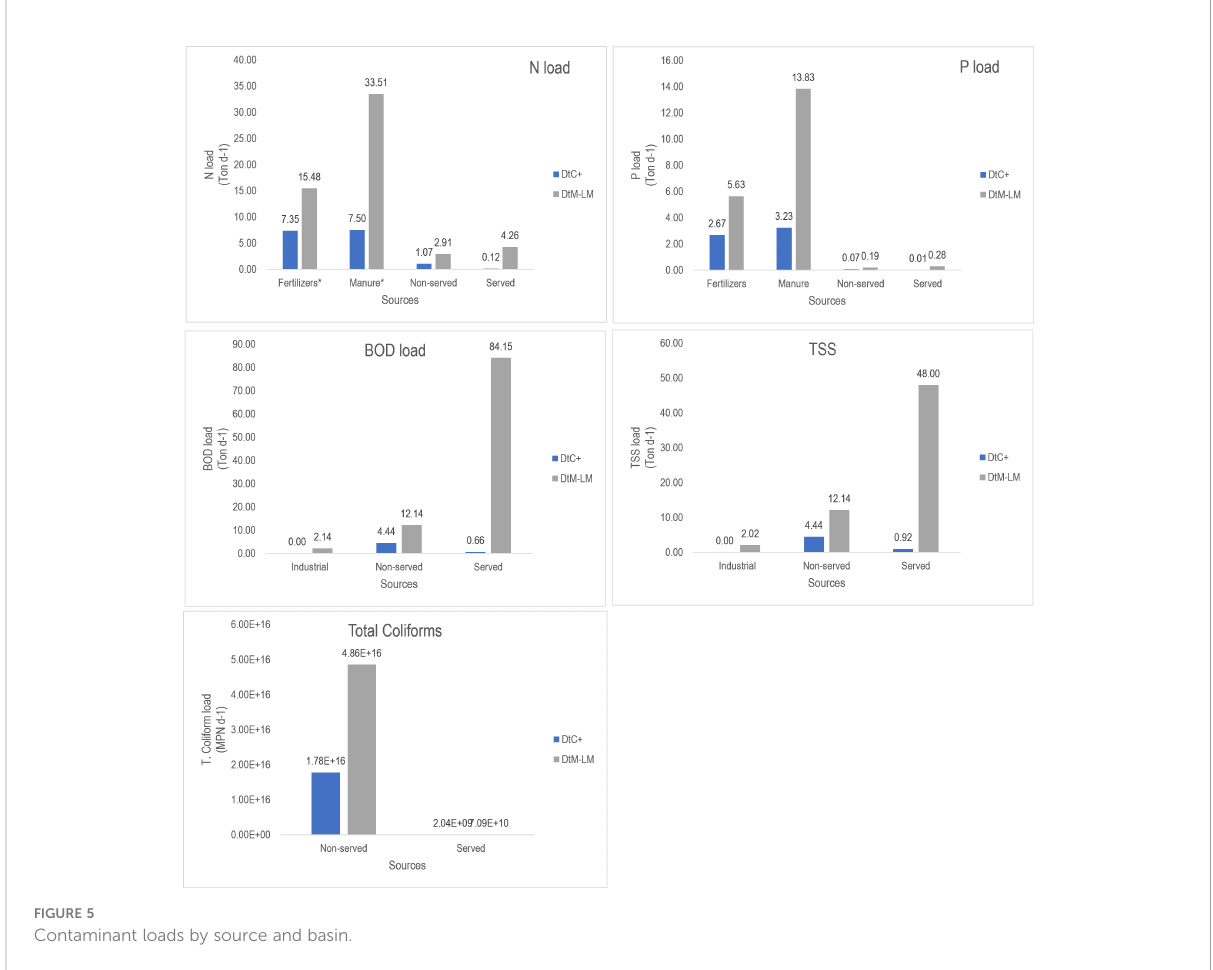
FIGURE 5 Contaminant loads by source and